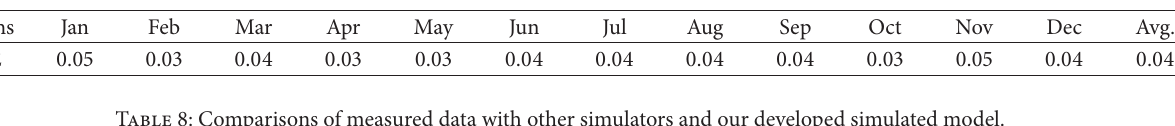
Table 7: The efficiencies of the proposed model.